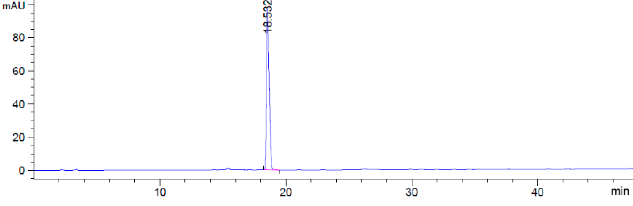
Figure 3. HPLC spectra of fragment C.